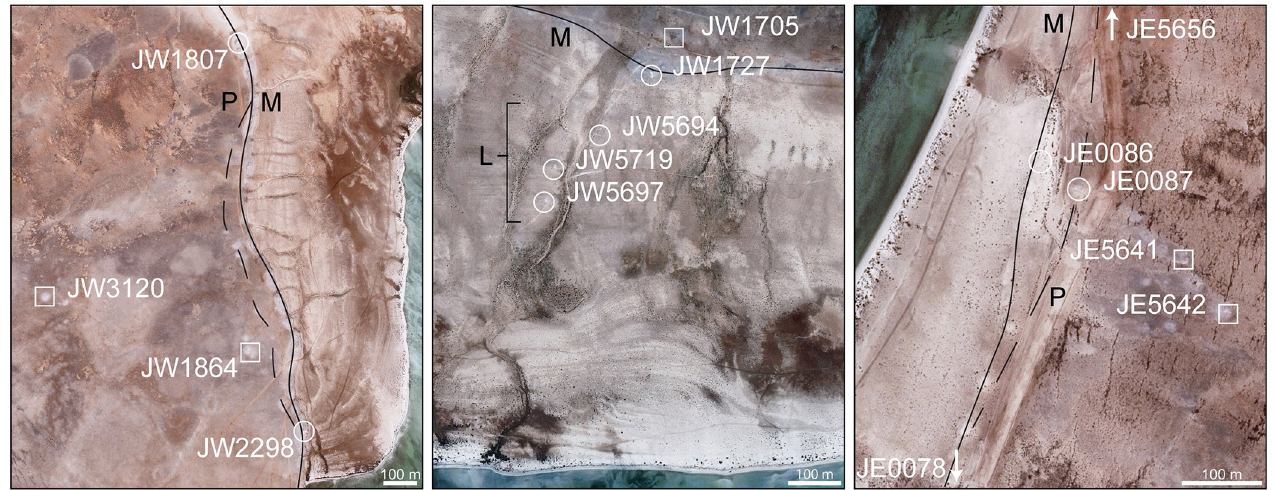
Fig 3. Sample transects showing the locations of radiocarbon-dated shell-midden sites superimposed on satellite imagery. Shoreline sites are indicated with a circle, post-shore sites are indicated with squares. Shorelines are indicated as follows: M: main shoreline, continuous black line; P: peak shoreline, dashed black line; L: lower shorelines, of which there are three in Transect 2, roughly parallel with the main shoreline as indicated by the square bracket.